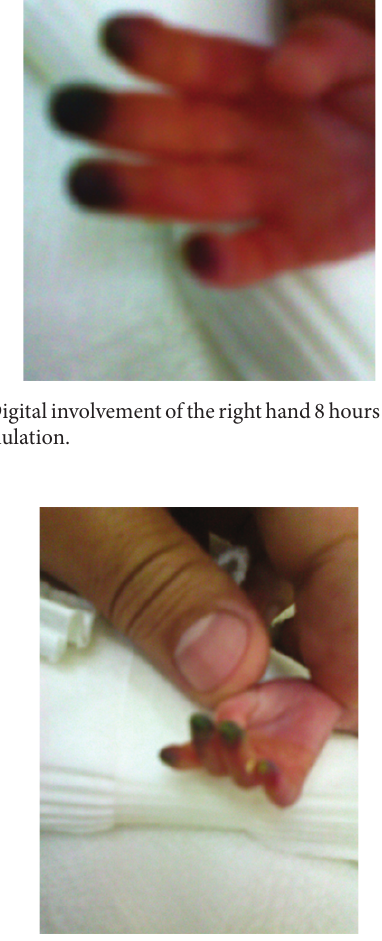
Figure 2: Signs of early necrosis in the finger